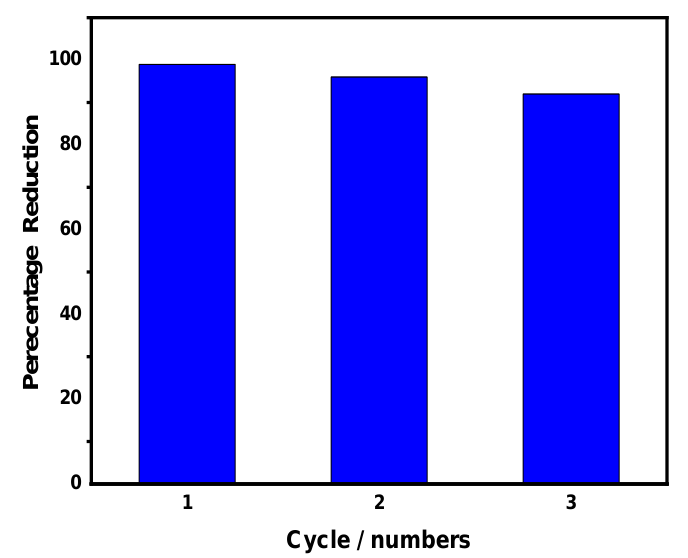
Figure 8. Efficiency of CuO nanoplate’s multiple usage in 4-NP reduction.